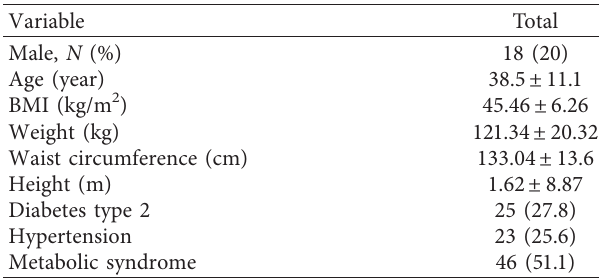
Table 1: Patient